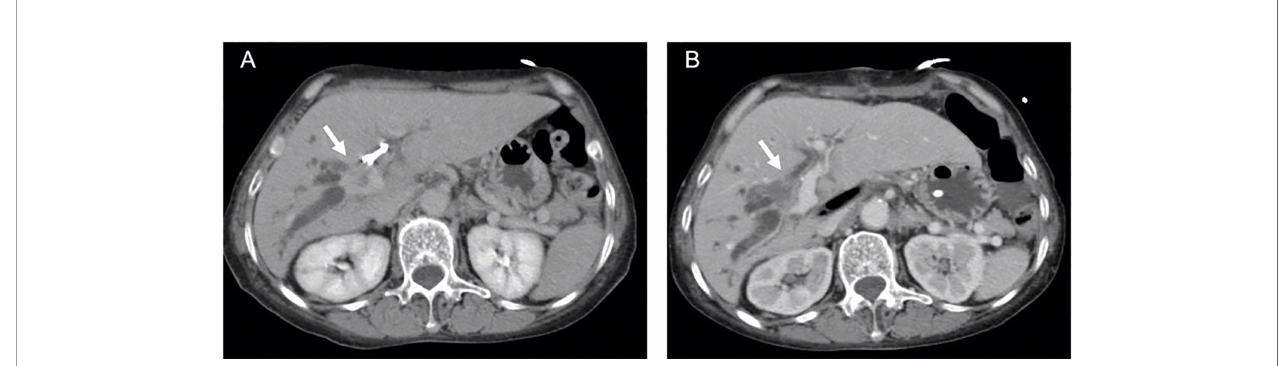
FIGURE 4 | (A) Arrow indicates enhanced Bismuth type IIIA perihilar cholangiocarcinoma (PHCC) with percutaneous biliary drainage (PTBD) tube in computed tomography (CT) scan. (B) No evidence of enhanced tumor (arrow) with patent biliary tract was observed in CT scan at one month after irreversible electroporation treatment (IRE).